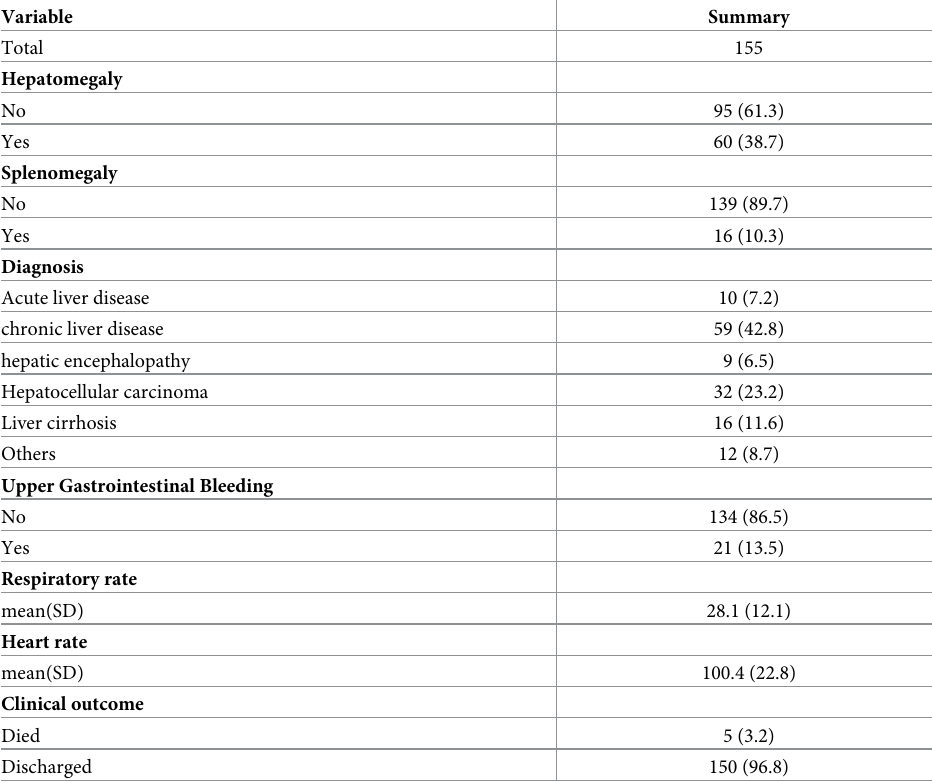
Table 3. Clinical characteristics of subjects.